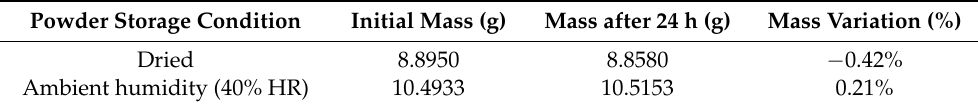
Table 6. Mass variation of the powder formulation depending on storage.